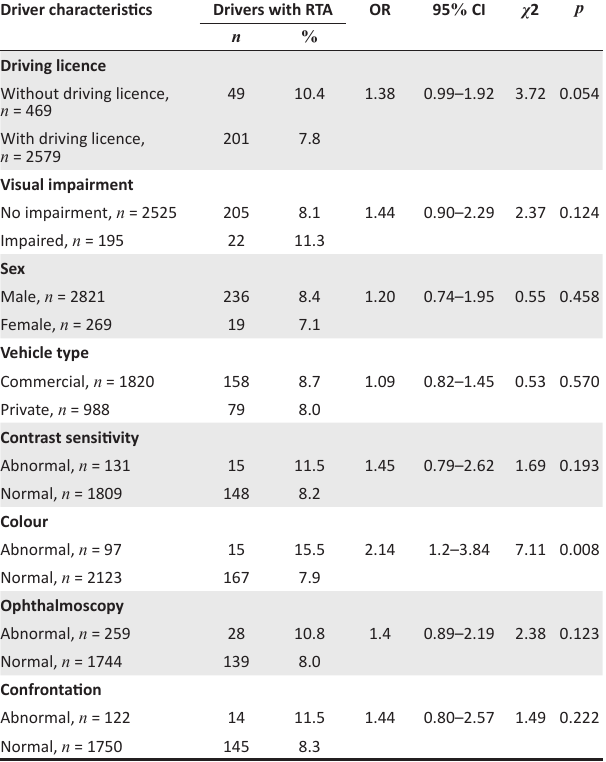
TABLE 4: Association between selected driver characteristics and history of road traffic accident. Driver characteristics